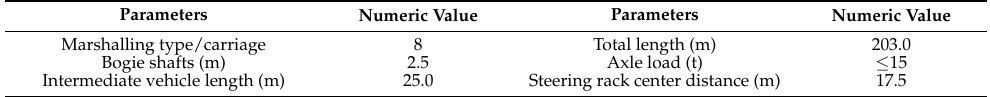
Table 3. CRH380 high-speed train parameters.